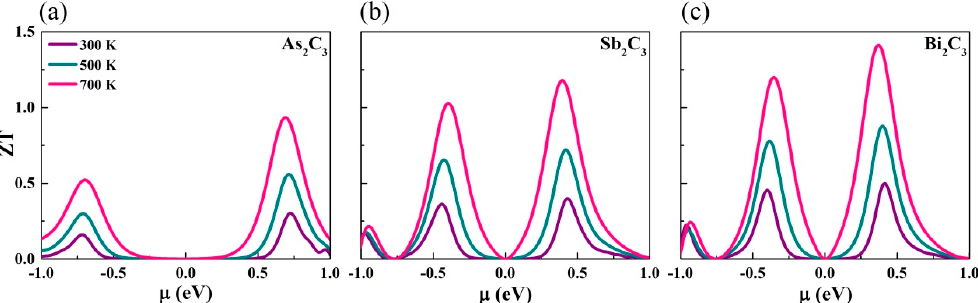
Figure 5. The thermoelectric figure of merit (ZT) versus the chemical potential of the ( a ) As 2 C 3 , ( b ) Sb 2 C 3 , and ( c ) Bi 2 C 3 at different temperatures.